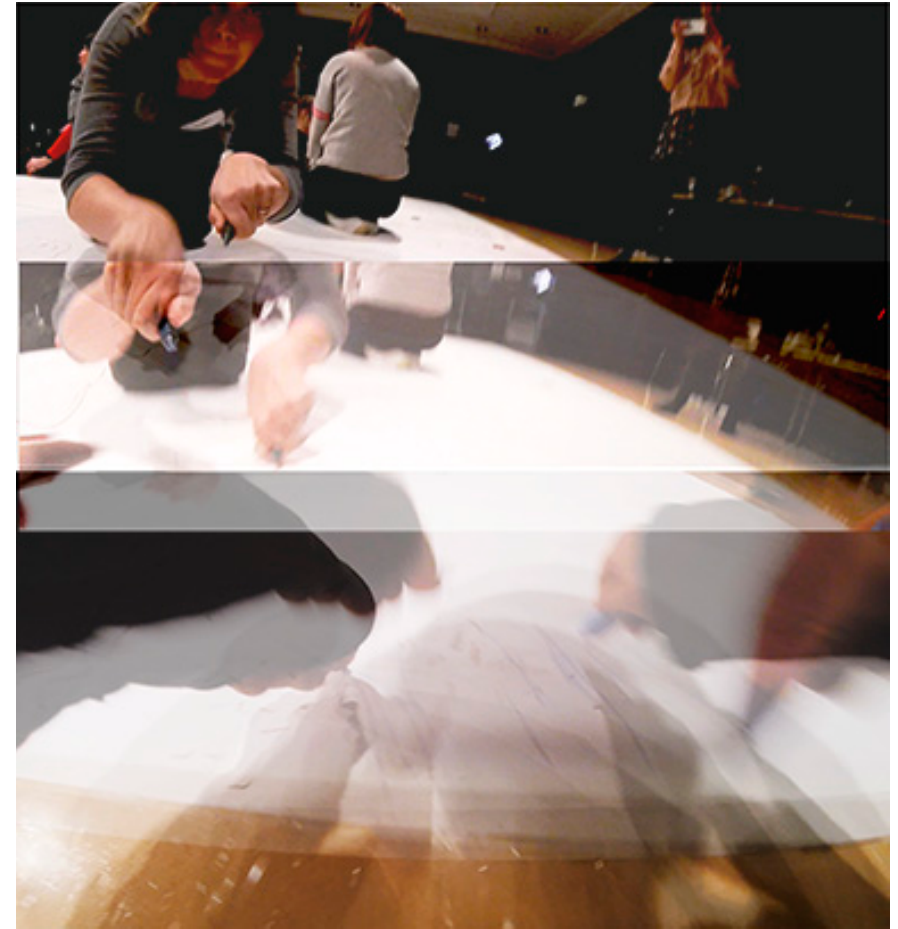
Figure 6. Nan and Elliot’s banginess .